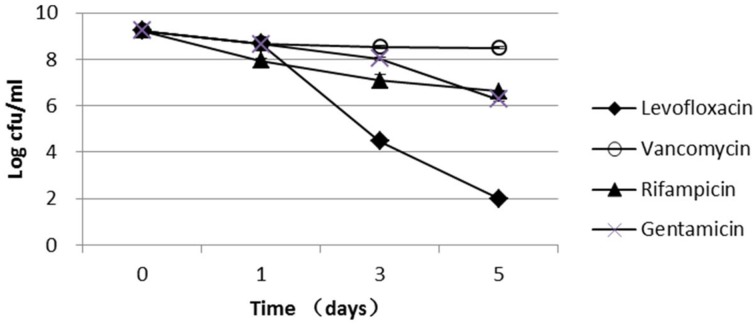
Persister levels of the parent S. aureus strain USA500 in drug exposure assays. Stationary-phase cultures of the wild-type USA500 were exposed to the different drugs, including levofloxacin (12.5 μg/ml), vancomycin (25 μg/ml), rifampicin (1.5 μg/ml), and gentamicin (100 μg/ml). The vertical axis represents CFU values in log scale, and the horizontal axis represents the time of exposure. The error bars indicate standard deviations.